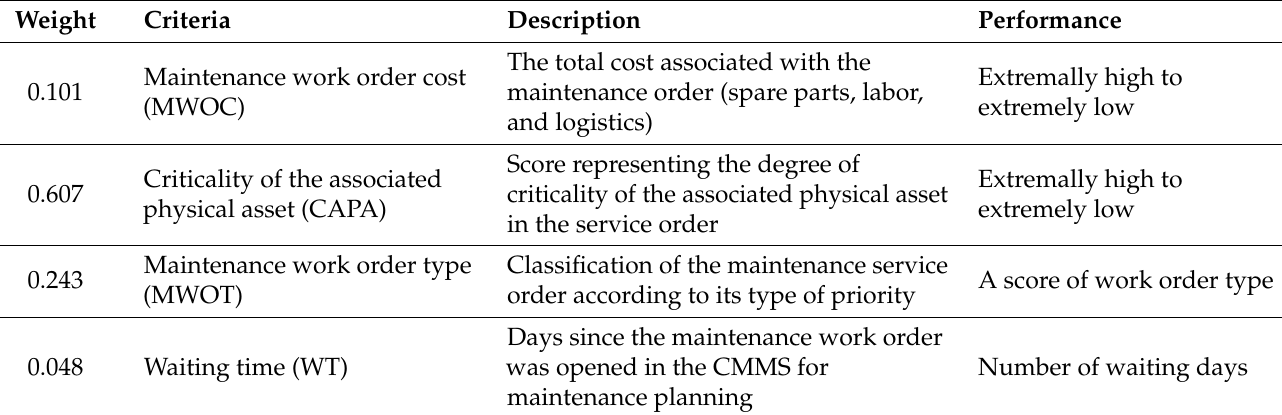
Table 5. Criteria and relative weights for prioritizing